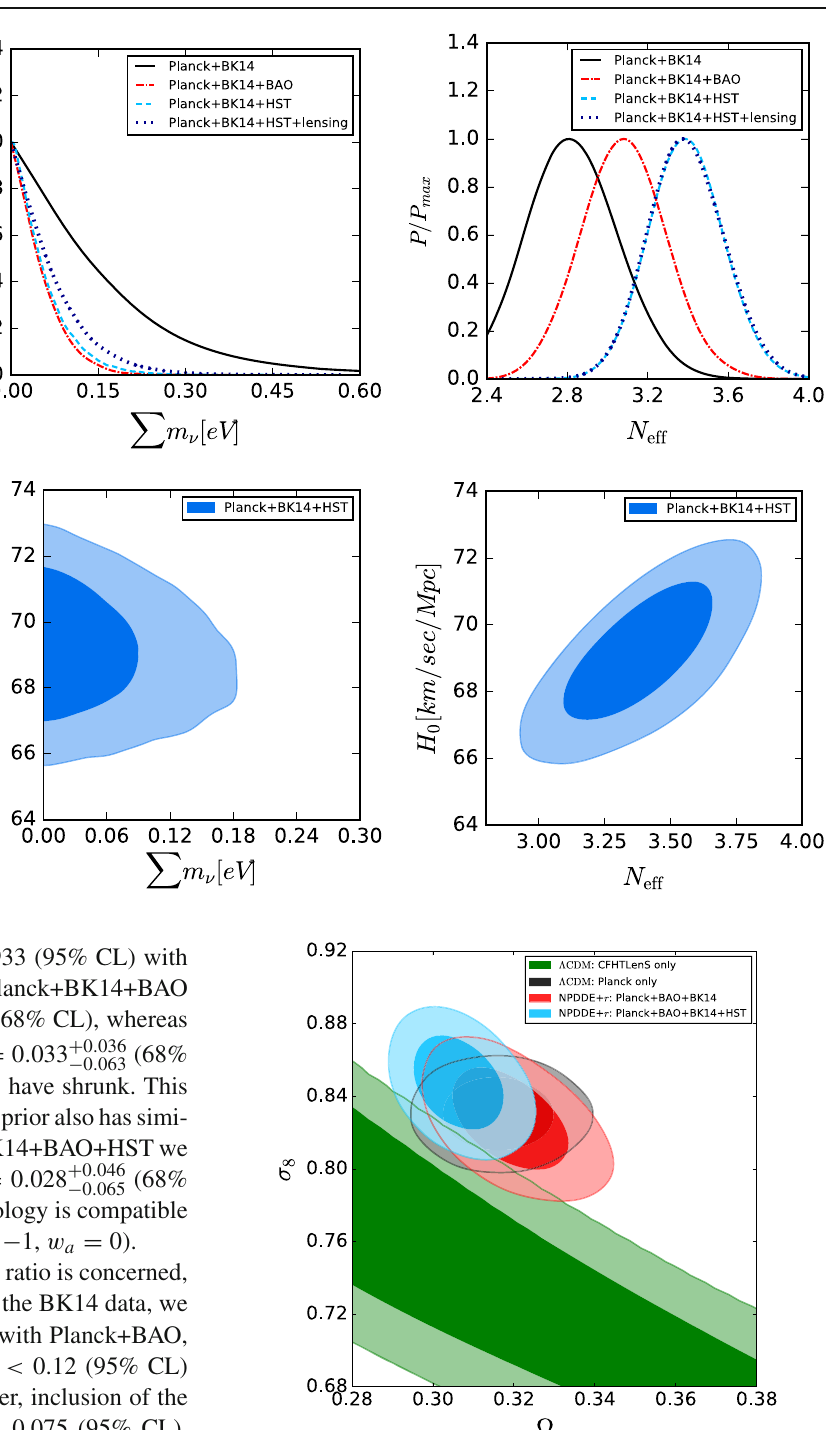
Fig. 3 1 σ and 2 σ marginalized contours in the σ 8 − (cid:6) m plane showing that the NPDDE+ r model is ineffective in reducing the tension between CFHTLenS and Planck